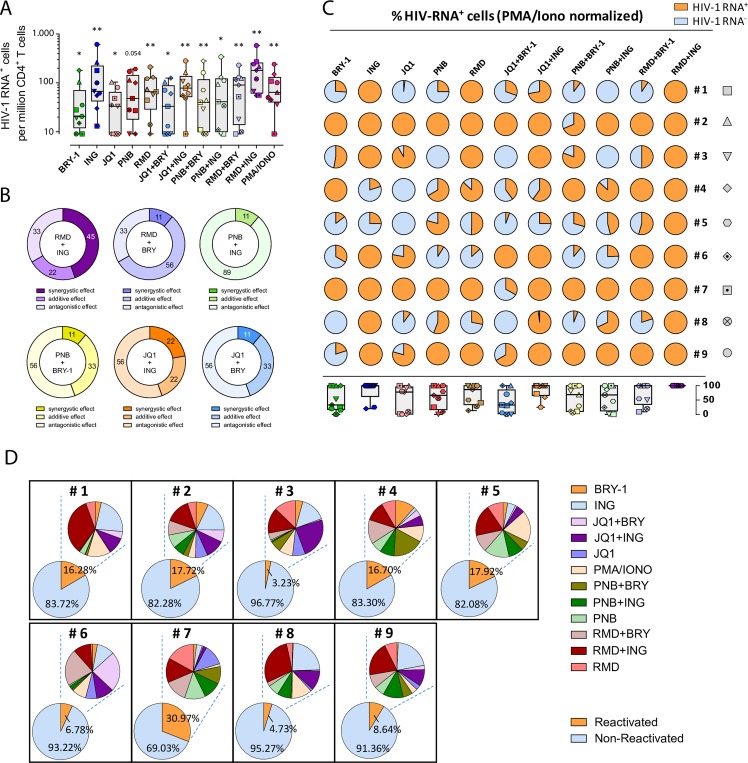
Detection of cells expressing HIV-1 RNA after viral reactivation with different LRAs.Freshly isolated CD4+ T cells from 9 ART-suppressed HIV-infected individuals were reactivated with different LRAs for 22h and subjected to the RNA FISH/flow protocol for detection of HIV transcripts. Drug concentrations were as follows: 40 nM Romidepsin (RMD), 30 nM Panobinostat (PNB), 1 μM JQ1, 100 nM Ingenol (ING), 10 nM Bryostatin-1 (BRY-1), 81 nM PMA plus 1 μM Ionomycin (IONO) or media alone. A. Proportion of cells expressing HIV-1 RNA in CD4+ T cells for each condition normalized to the medium control from individual patients are shown. Medians and min and max ranks are represented and statistical comparisons with the control medium were performed using the Wilcoxon test. *p<0.05, **p<0.01. B. Percentage of patients showing synergistic, antagonistic or additive effects (Bliss independence model) on HIV reactivation are shown as individual ring graphs for each combination of different LRA families studied. C. Proportion of HIV-transcribing cells relative to the positive control PMA/Ionomycin. Pies for individual patients normalized to the positive control and median values for all patients are represented in a box and whisker plot graph. HIV-1 RNA+ and HIV-1 RNA- fractions are shown in orange and blue, respectively. D. Fraction of the HIV-reservoir susceptible to HIV reactivation after LRA treatment in CD4+ T cells from 9 ART-suppressed patients. Lower pies show the proportion of reactivated and non-reactivated cells. Upper pies show the fraction of reactivated cells after treatment with each compound depicted in the adjacent legend. We next calculated the percentage of the HIV-transcriptionally active viral reservoir after exogenous reactivation with the LRAs. We observed that between 3 and 31% (median value of 16.28%) of the total cells that encompass the viral reservoir (measured as the number of cells containing proviral DNA) were capable of transcribing HIV-1 RNA after viral reactivation (Fig 2D). The potency of each LRAs and their combinations in each individual patient is also shown in Fig 2D. Thus, while in general only a fraction of cells harboring HIV-1 DNA can be reactivated by current available LRAs, differences in terms of strength and consistency of this viral reactivation are observed in the whole population of CD4+ T cells from different ART-treated individuals.